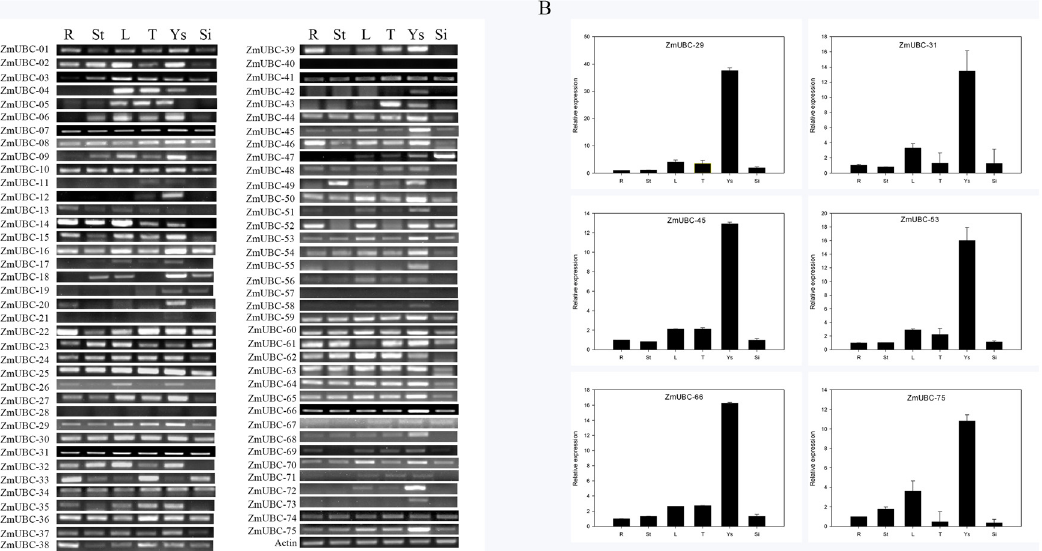
Fig 4. Tissue-specific expression of ZmUBC genes. (A) Semi-quantitative RT-PCR analysis of ZmUBC genes. (B) RT-qPCR analysis of representative ZmUBC genes. The letter R above the column of the expression data refers to root, St represents stem, L indicates leaf, T refers to tassel, Ys indicates young seed, and Si represents